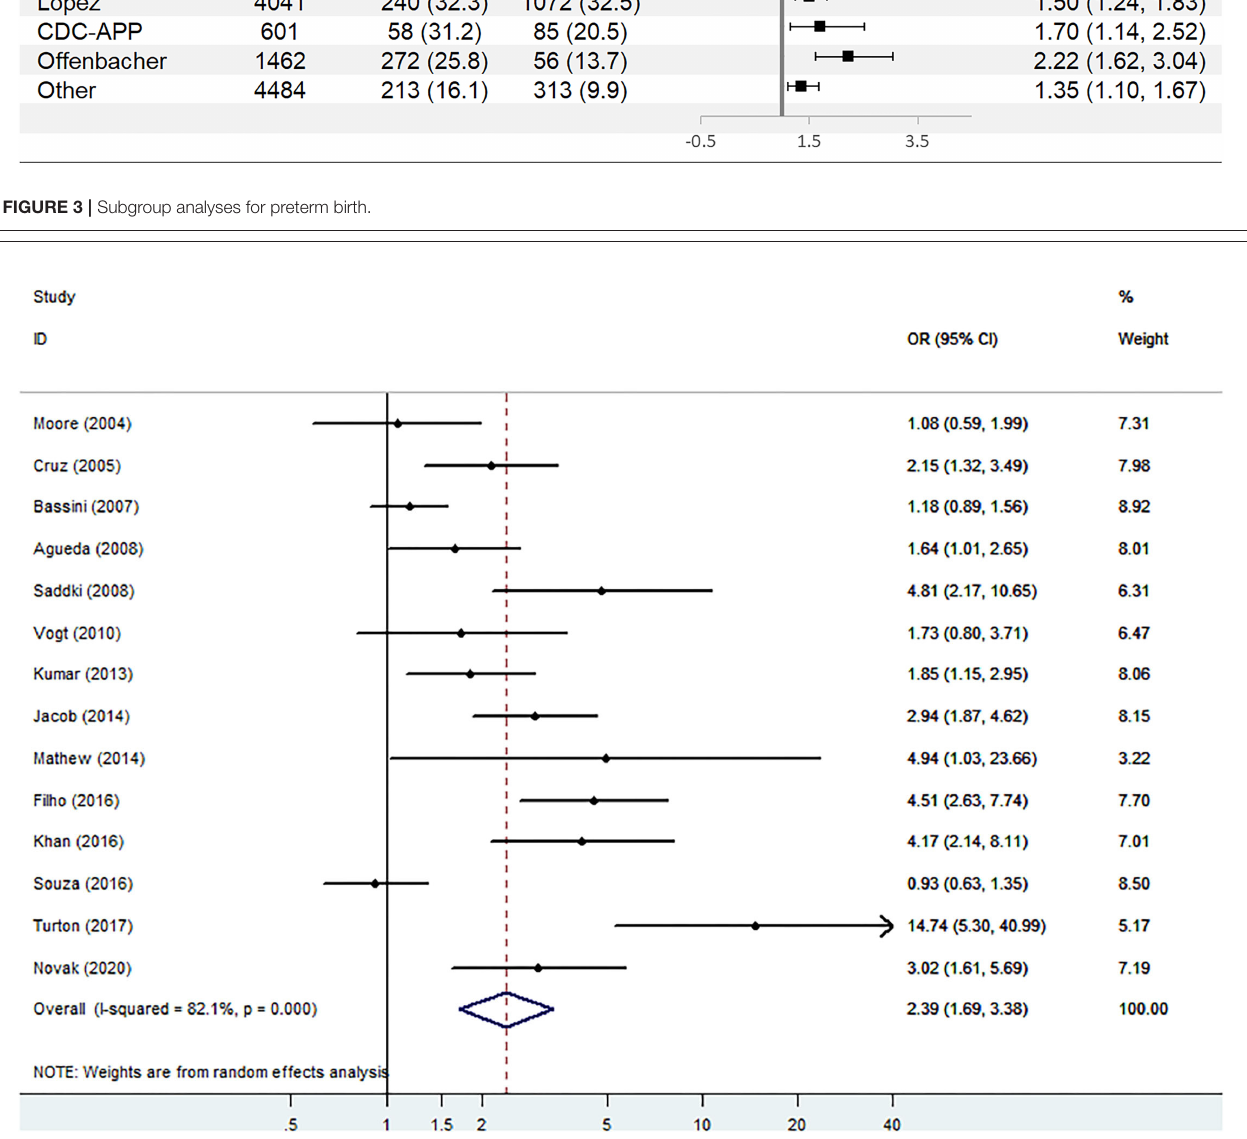
FIGURE 4 | Forest plot of low birth weight (LBW)